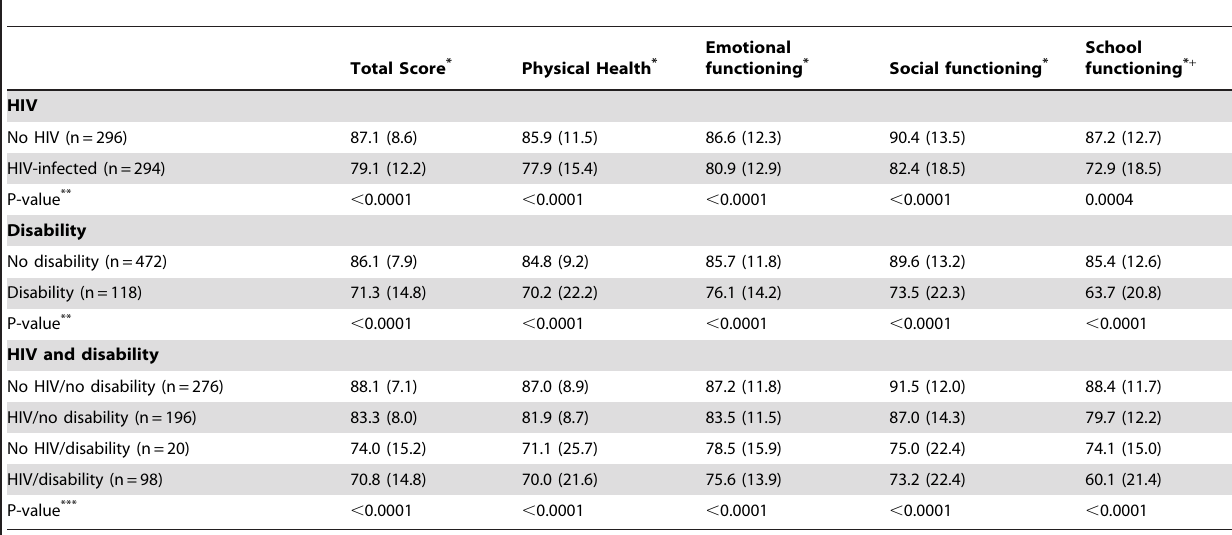
Table 3. PedsQL Inventory Scores comparing children by HIV status and presence of disability.